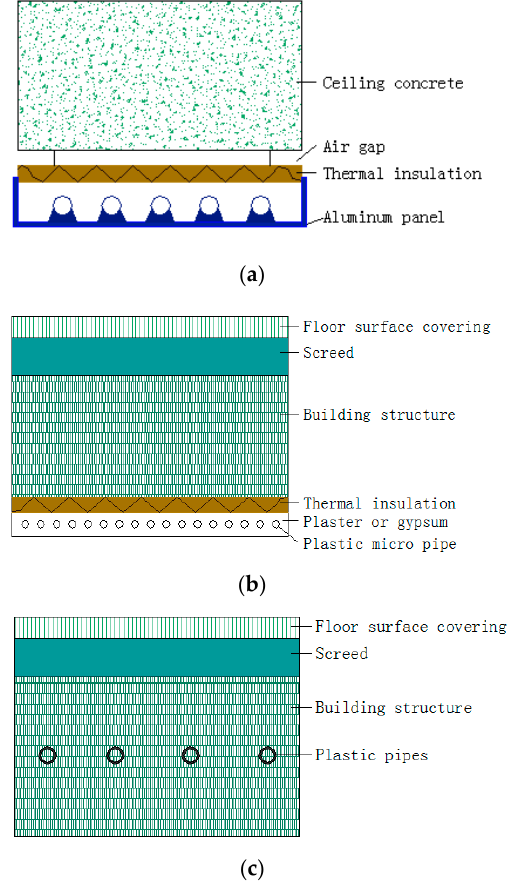
Figure 1. Types of radiant cooling systems. ( a ) Radiant panel system; ( b ) embedded surface system and ( c ) thermally activated building system [6,16].